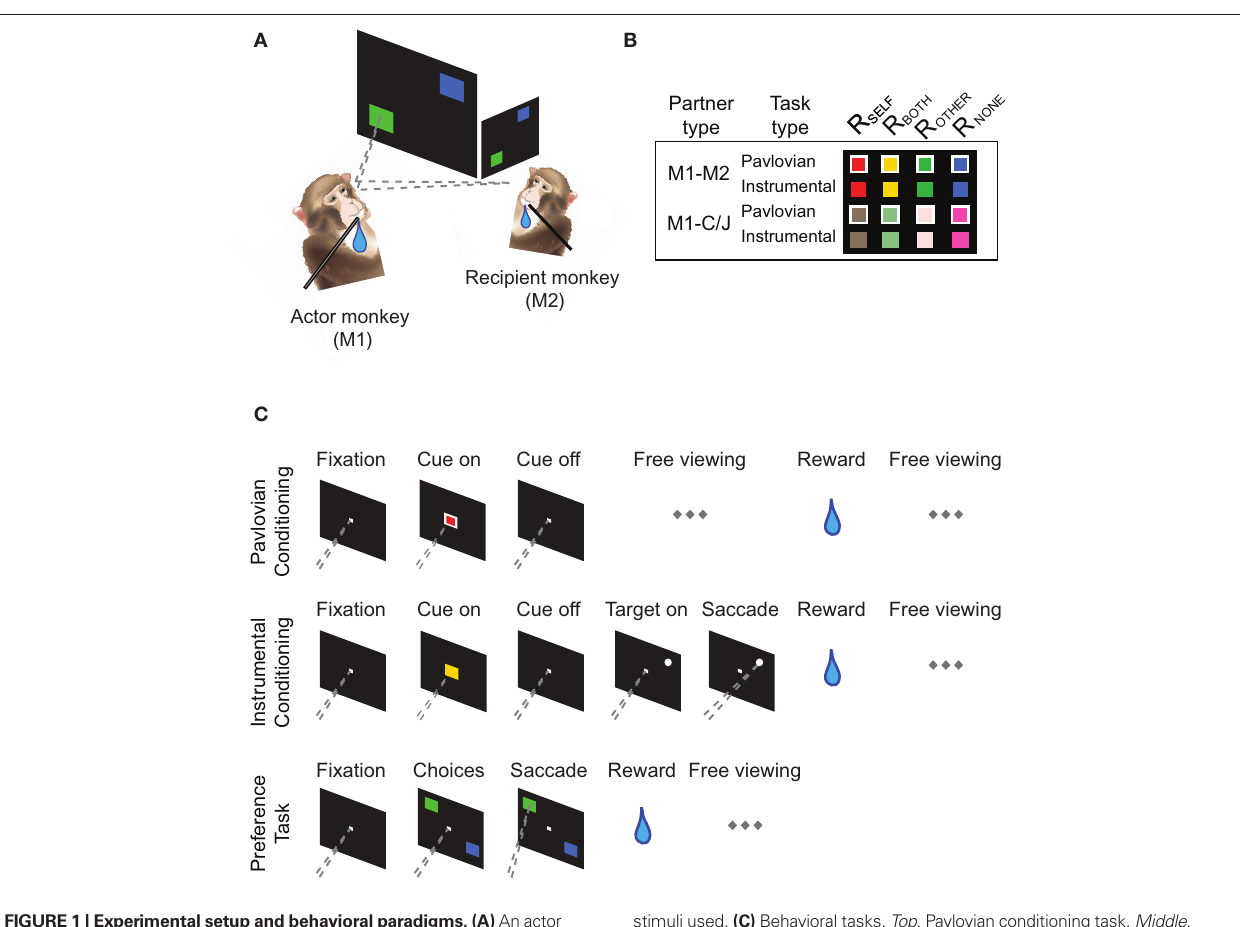
stimuli used. (C) Behavioral tasks. Top , Pavlovian conditioning task. Middle , instrumental conditioning task. Bottom , preference task. Pavlovian